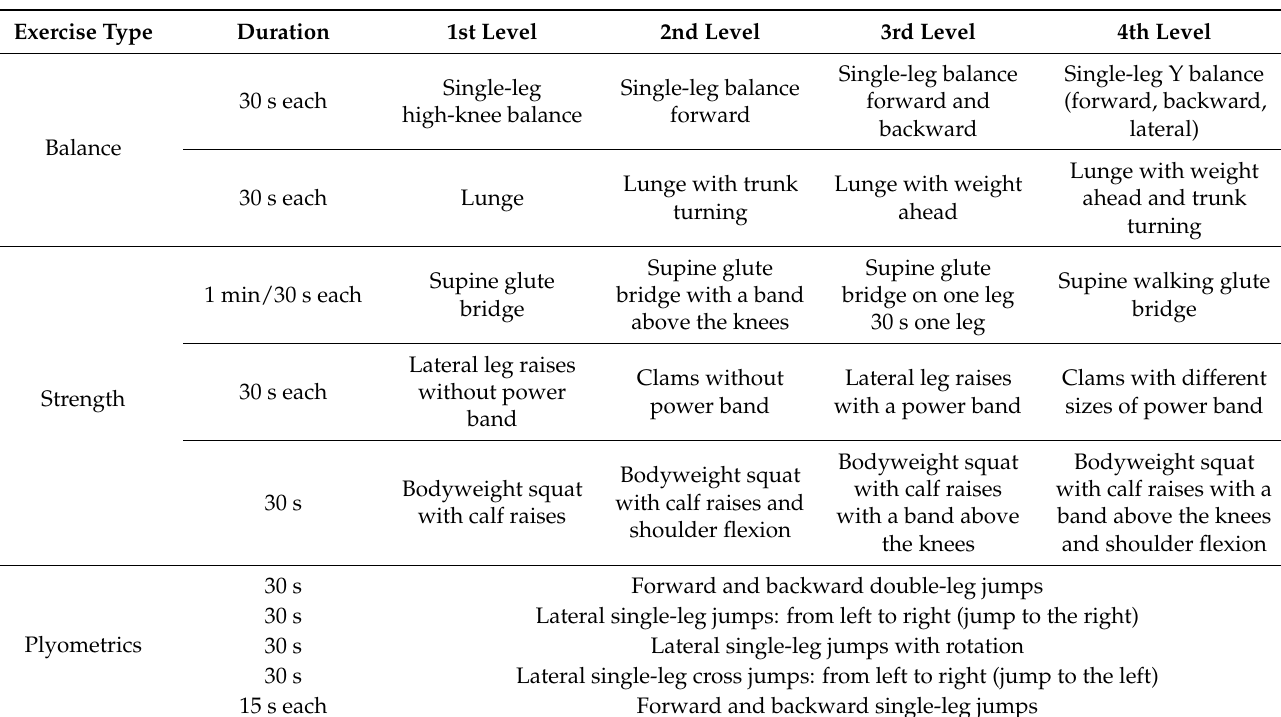
Table 1. KneeRugbyWomen